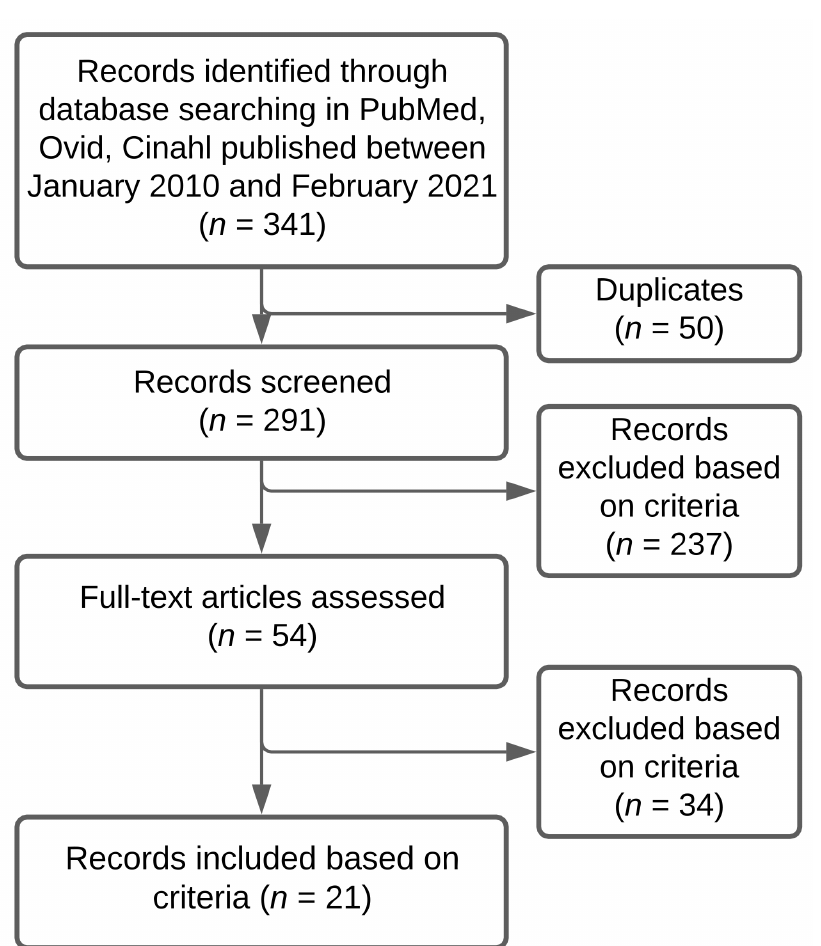
Figure 2. Selection process for articles about IBD and DH or AI in diagnosis, treatment, monitor- ing, or prognosis. Describes the trajectory of reviewing articles based on screening process and selection